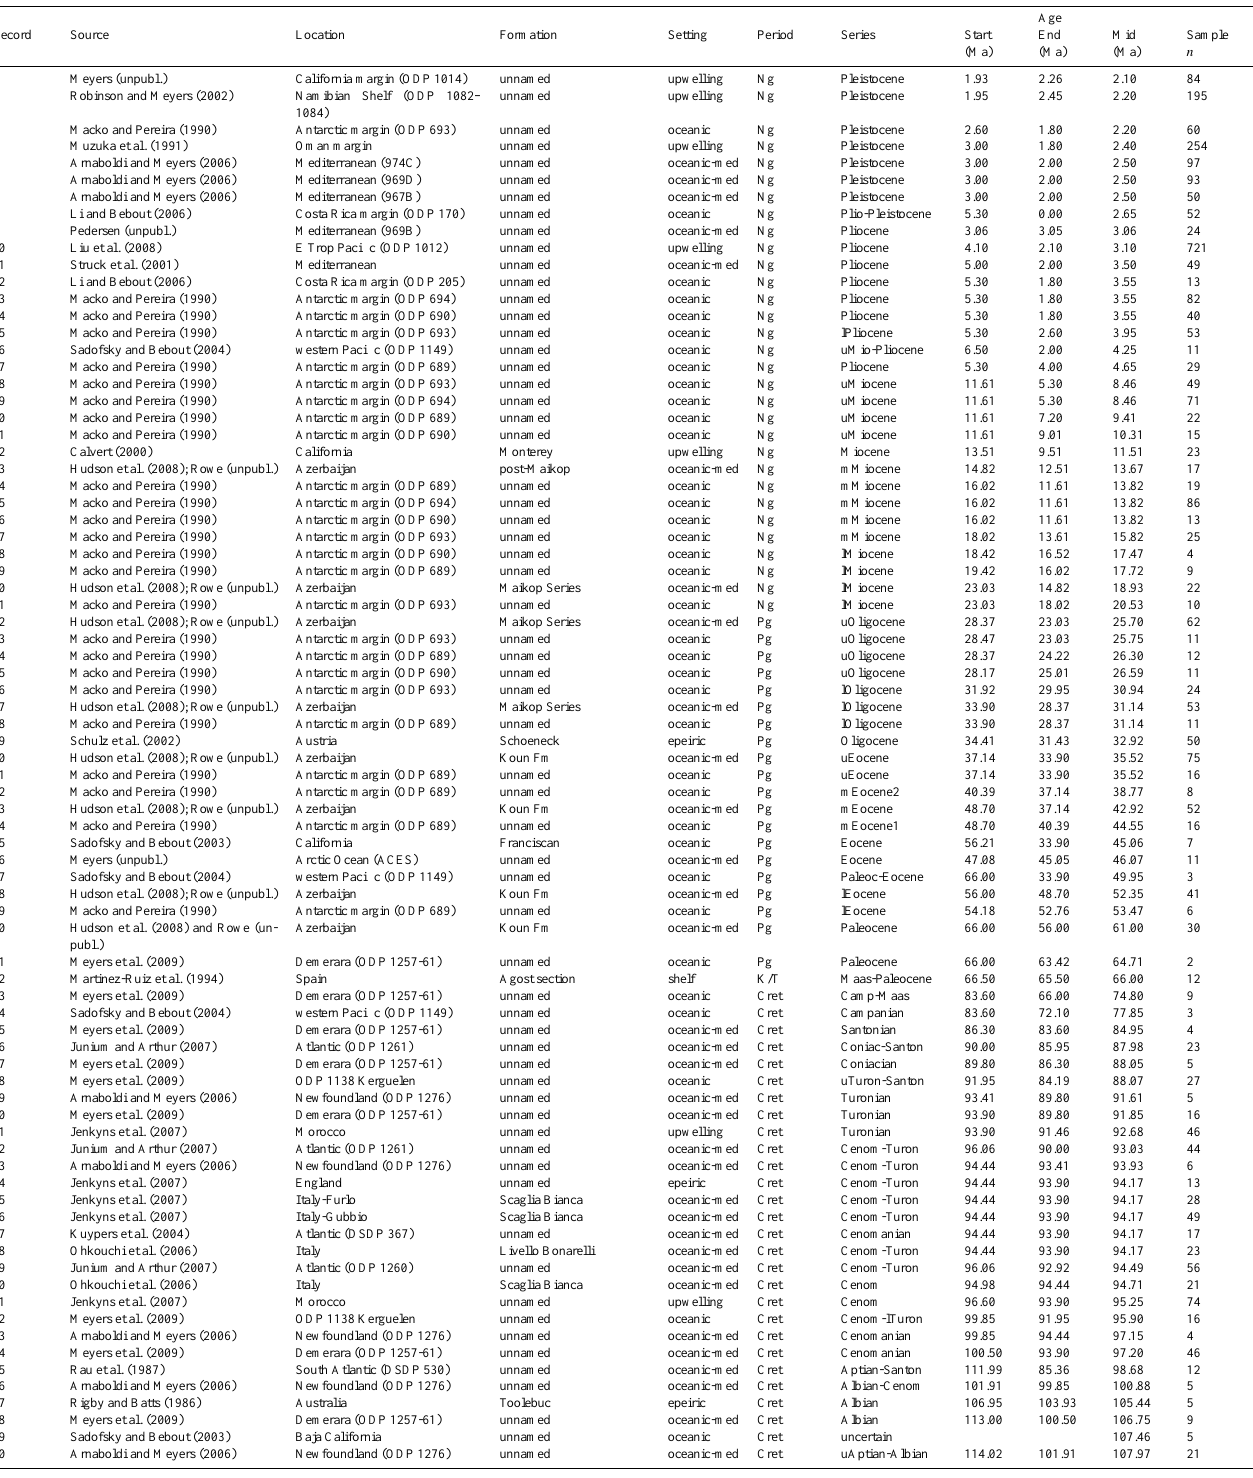
Table 1. N-isotope and correlative data for 153 marine units from 660 Ma to Recent.